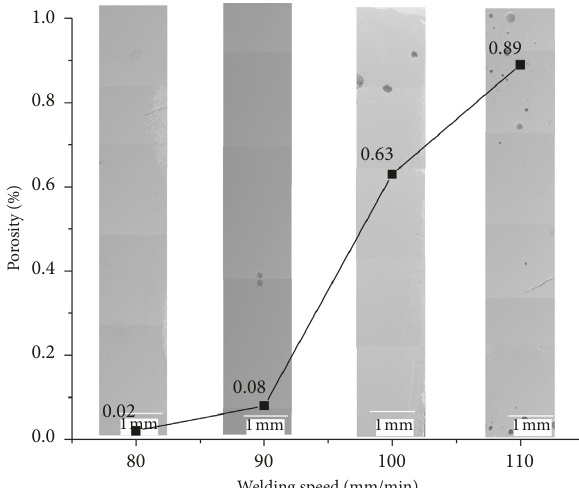
Figure 2: Pore distribution and porosity change curve of the sealing layer at different welding speeds.